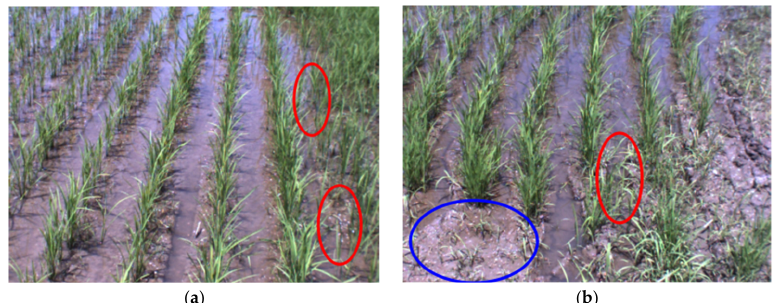
Figure 2. Images of rice seedlings: ( a ) Images of rice seedlings under sunny skies; ( b ) Images of rice seedlings under cloudy skies; The red circles represent the location of weeds; The blue circles represent the location of lacking seedlings.